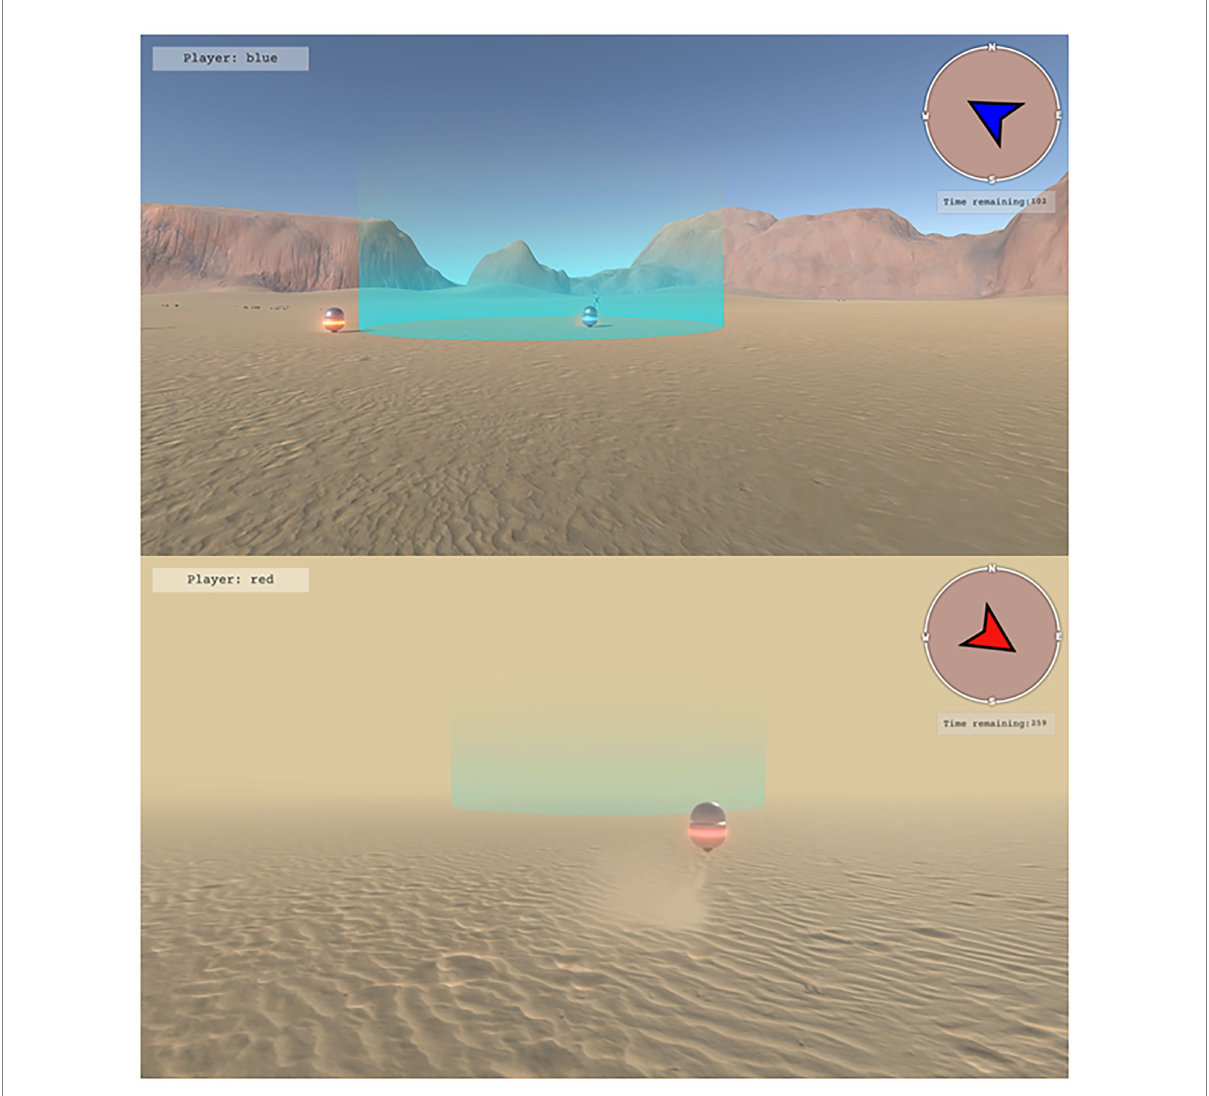
FIGURE 2 Ground player view of task manipulations. Participants playing as ground players used keyboard and mouse controls to navigate their humanoid avatars across a large desert environment. Teams consisted of three ground players who were tasked to search, corral, and contain target agents (TAs) within the cyan containment area. Ground players’ ability to observe the environment was manipulated by controlling the absence (top) or presence (bottom) of environmental fog. Participants either had full visibility of the desert environment (top), or their vision was obscured by fog (bottom). Ground players had access to a compass (top right of each image), a timer indicating how much time was remaining in a trial, and a nametag (top left of each image) reminding the participant of their name in the